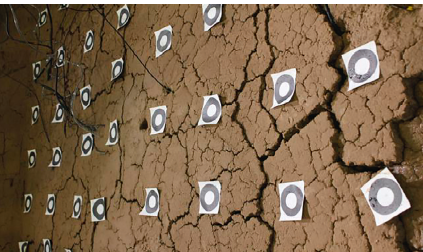
Figure 21: Loess slope surface at the 976gal.